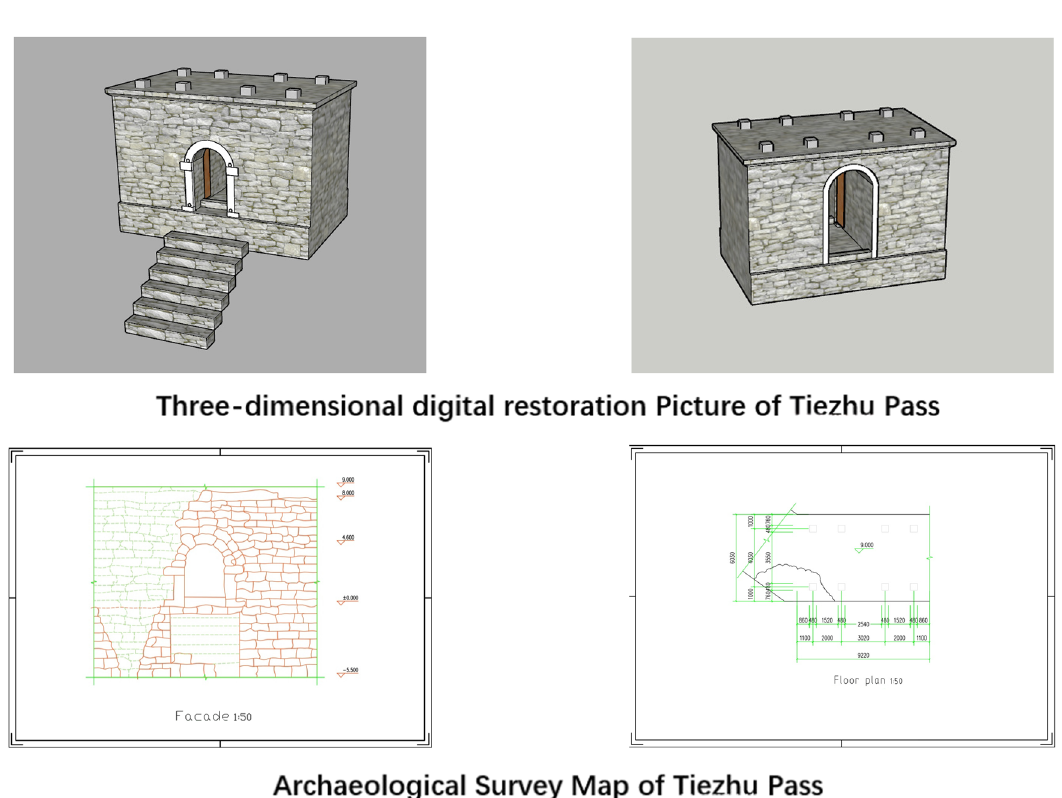
Figure 5: Mapping and restoration sets used in the system for heritage